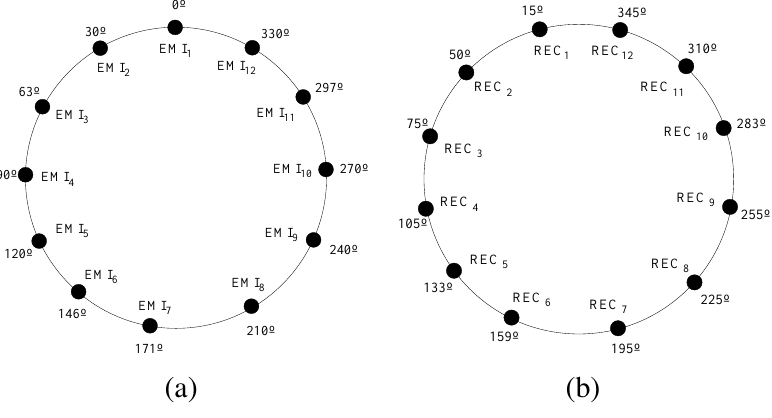
Figure 2. (a) Emitters and (b) receivers distribution around the perimeter of the